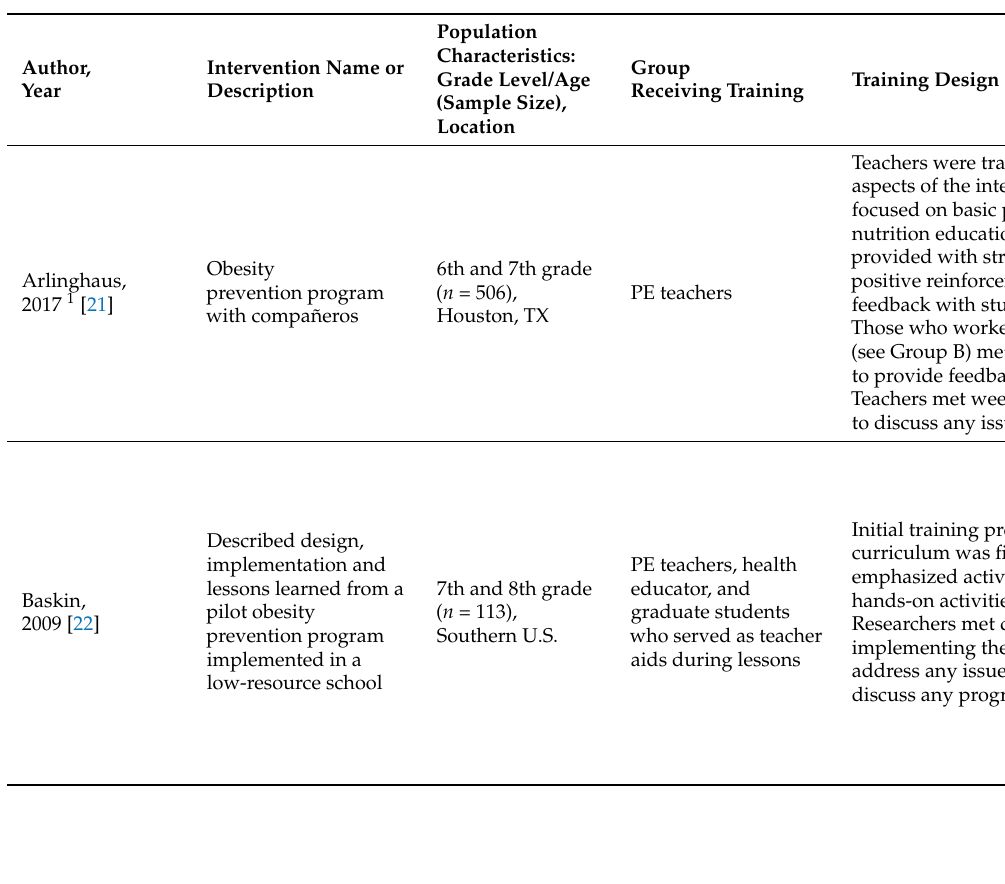
Table 2. Group A: Classroom-based interventions that trained